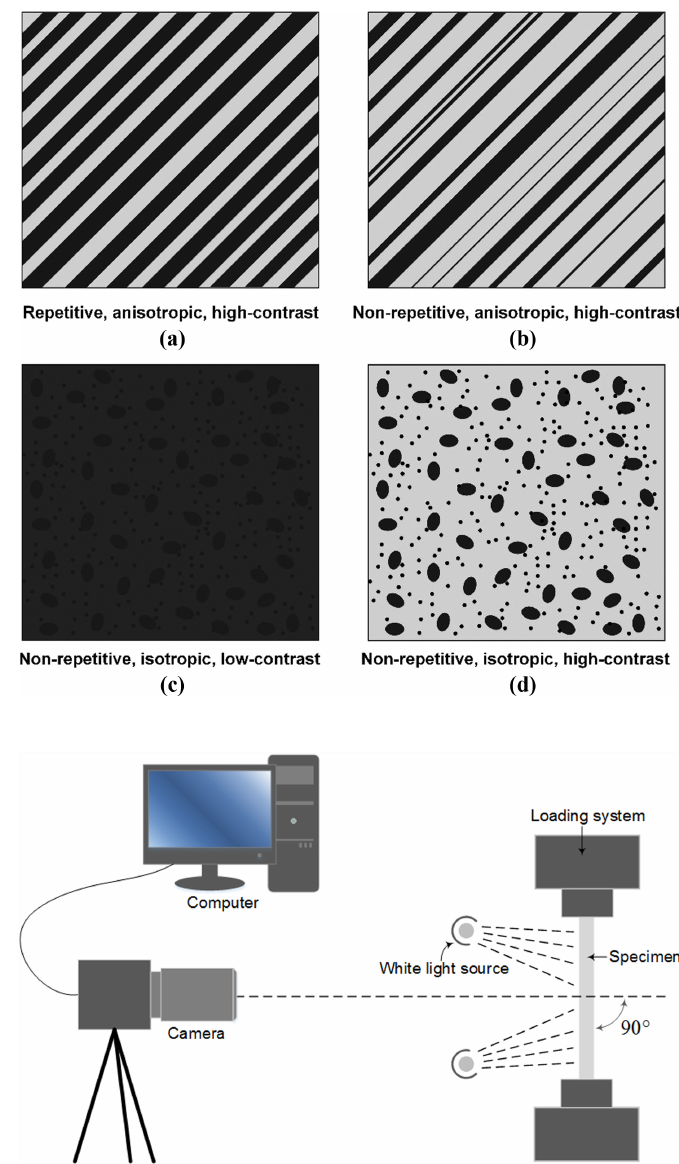
CMOS); (3) a computer for data acquisition and (4) a white light source. More specifically, the camera is placed on a tripod so that its optical axis is perpendicular to the sample surface. The white light source is intended to provide a good view of the surface of the specimen with a high-contrast grayscale intensity distribution. When the specimen is loaded, the camera records images of the specimen during the deformation process. The acquired images are